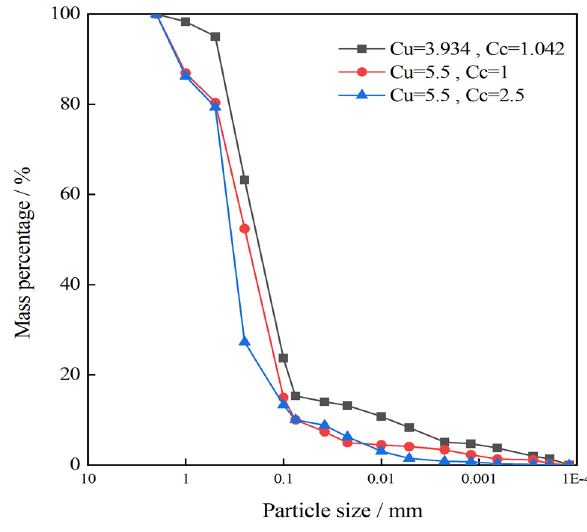
Figure 18. Grading curves of tailing sand.